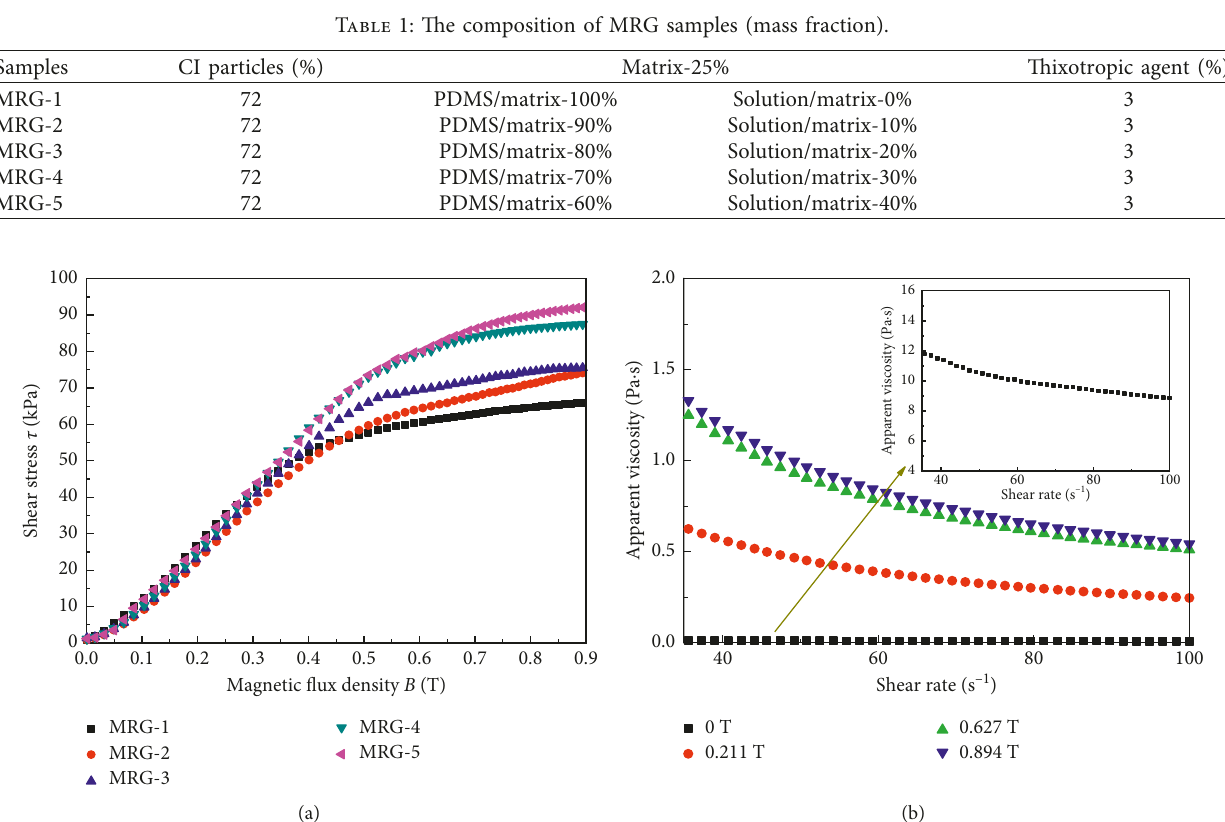
Figure 2: (a) The shear stress stimulated by different magnetic flux density for MRG-1 to MRG-5 and (b) the apparent viscosity of MRG-5 versus shear